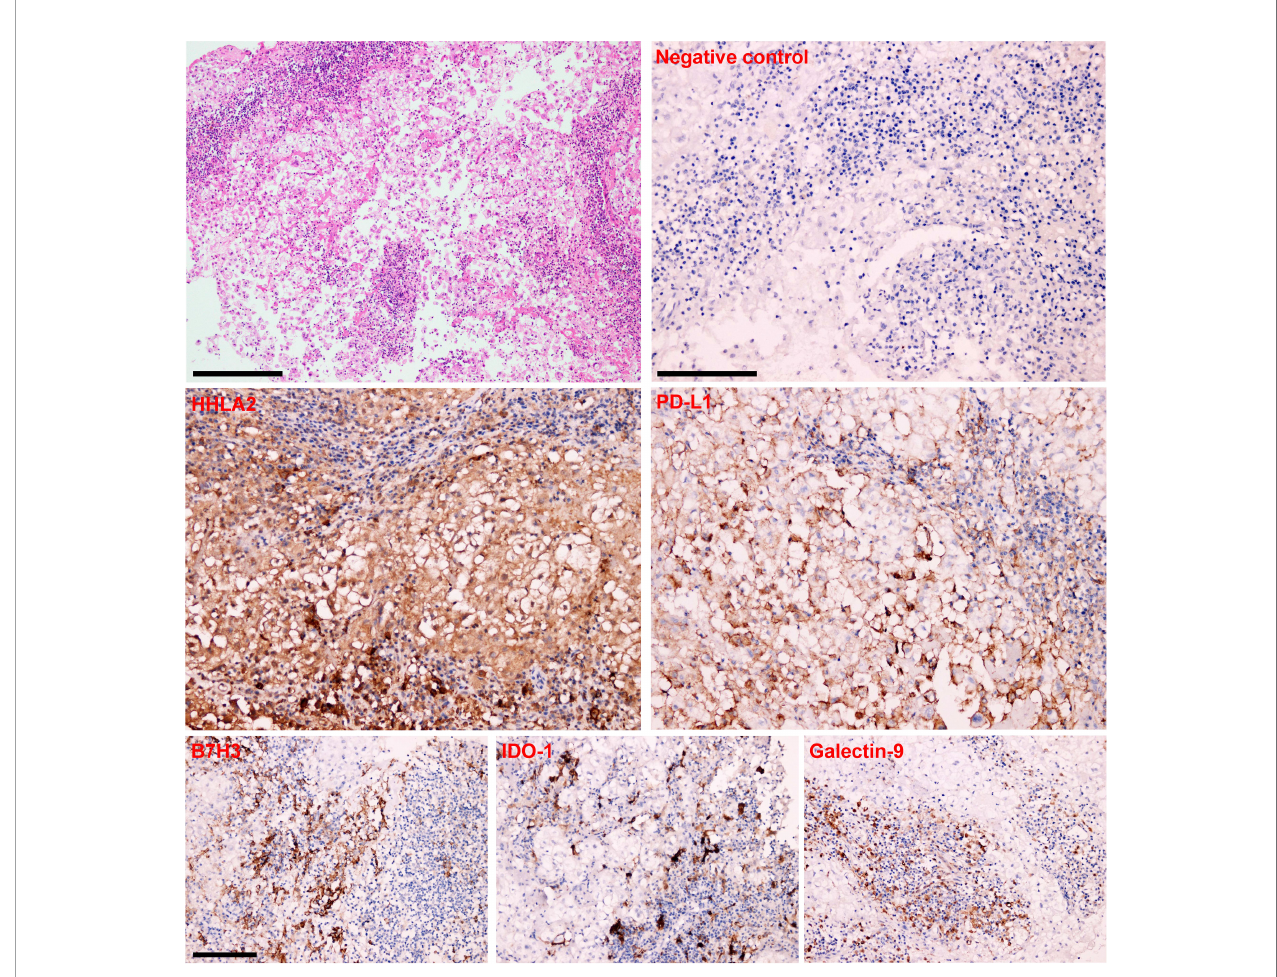
FIGURE 1 | HE staining and Immunohistochemistry analysis in human spinal chordoma tissues. Representative immunohistochemistry images showing the negative control and positive expression of HHLA2, B7H3, IDO-1, PD-L1 and Galectin-9 in a chordoma sample. Scale bar = 100 m